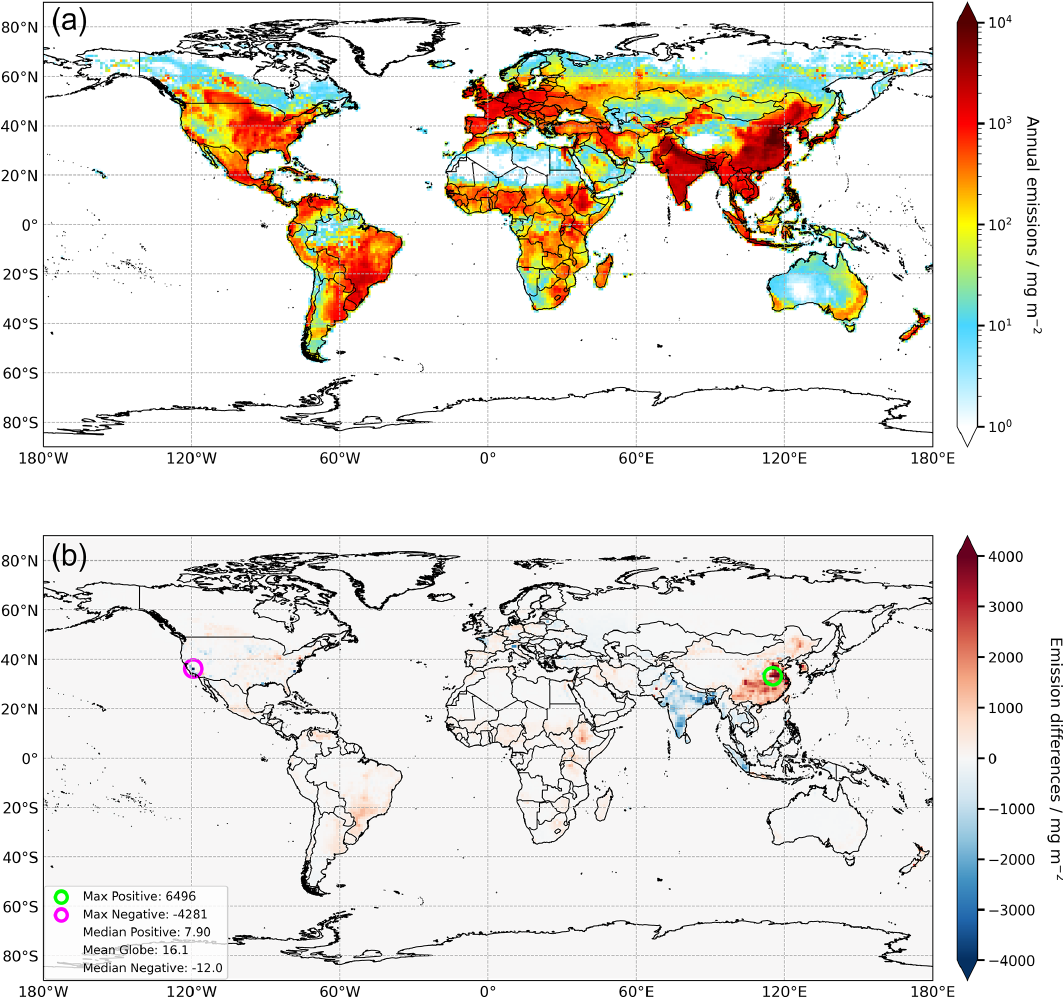
Figure 2. (a) Global annual NH 3 emissions for 2010 from ECLIPSE E . (b) The difference in 2010 annual NH 3 emissions (mgm − 2 ) between ECLIPSE E and HTAP (ECLIPSE E – HTAP). The inset panel provides the maximum, median, and mean values of both positive and negative differences across individual emission